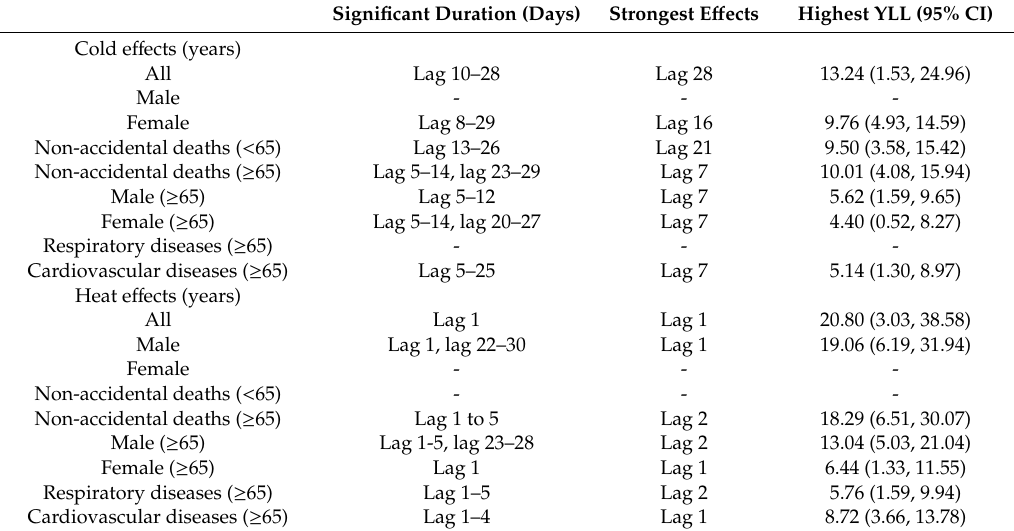
Table 2. Significant durations and strongest single-day lag e ff ects of cold and heat for di ff erent subgroups in Lanzhou City.